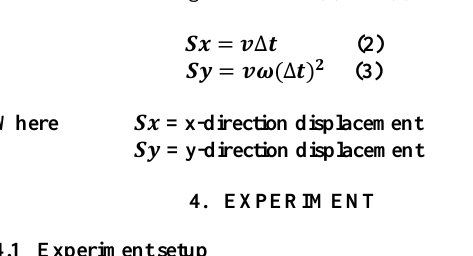
Figure 5. The displacement between t and t-1 can be calculated using the formula (2) and (3).